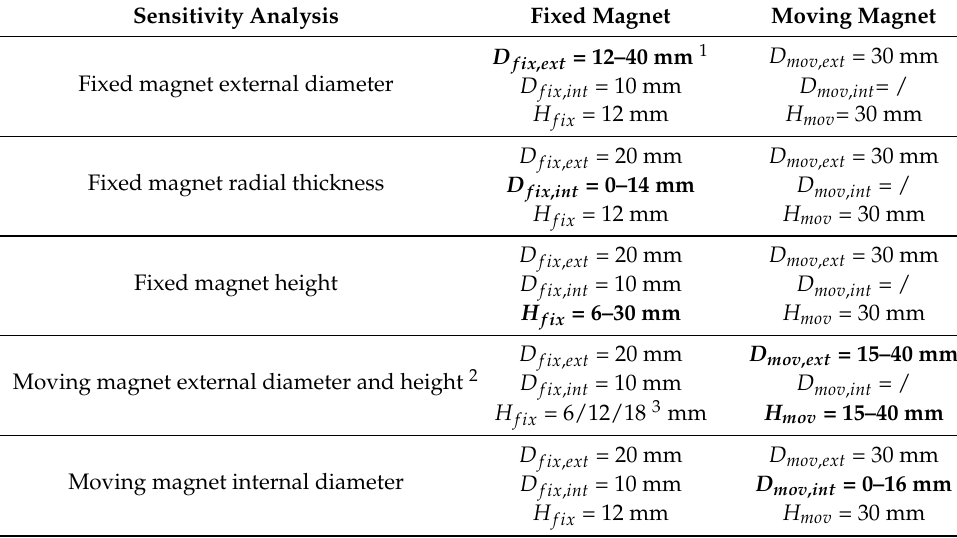
Table 8. Sensitivity analyses